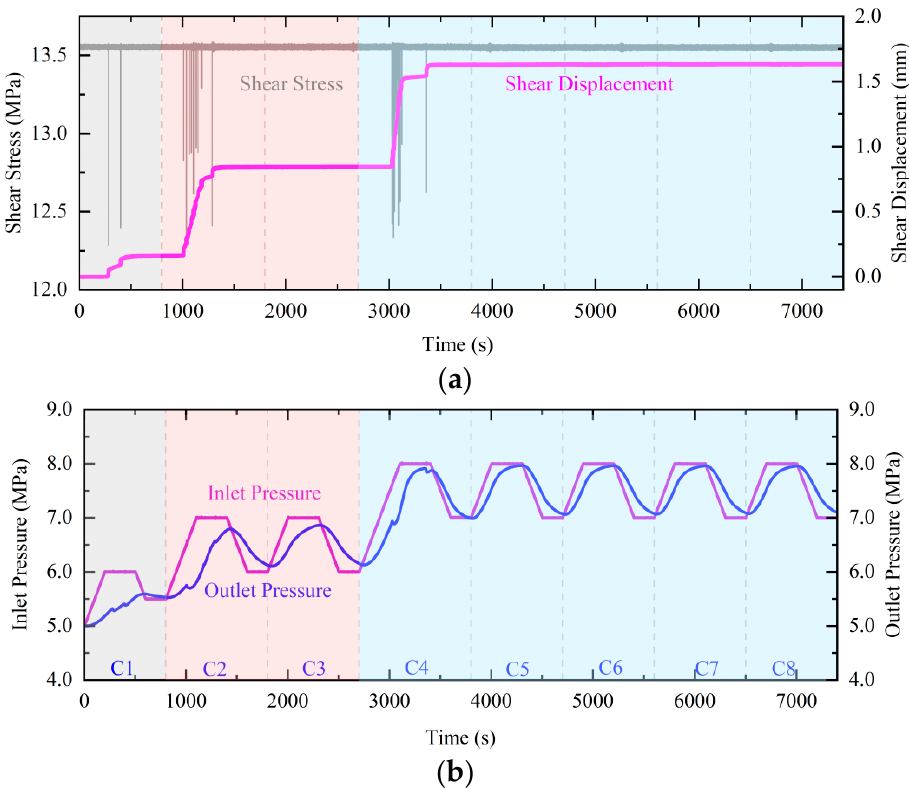
Figure 6. The cyclic pressurization instability of a saw-cut fracture. ( a ) The shear stress and shear displacement with shearing time; ( b ) The inlet pressure and outlet pressure with shearing time.